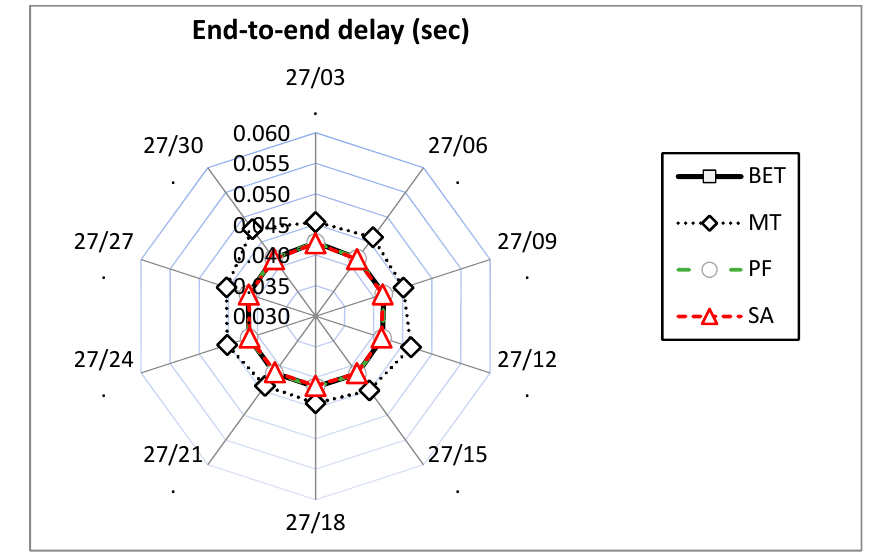
Figure 9. Average packet end-to-end delay for voice cell-edge users in mixed traffic.